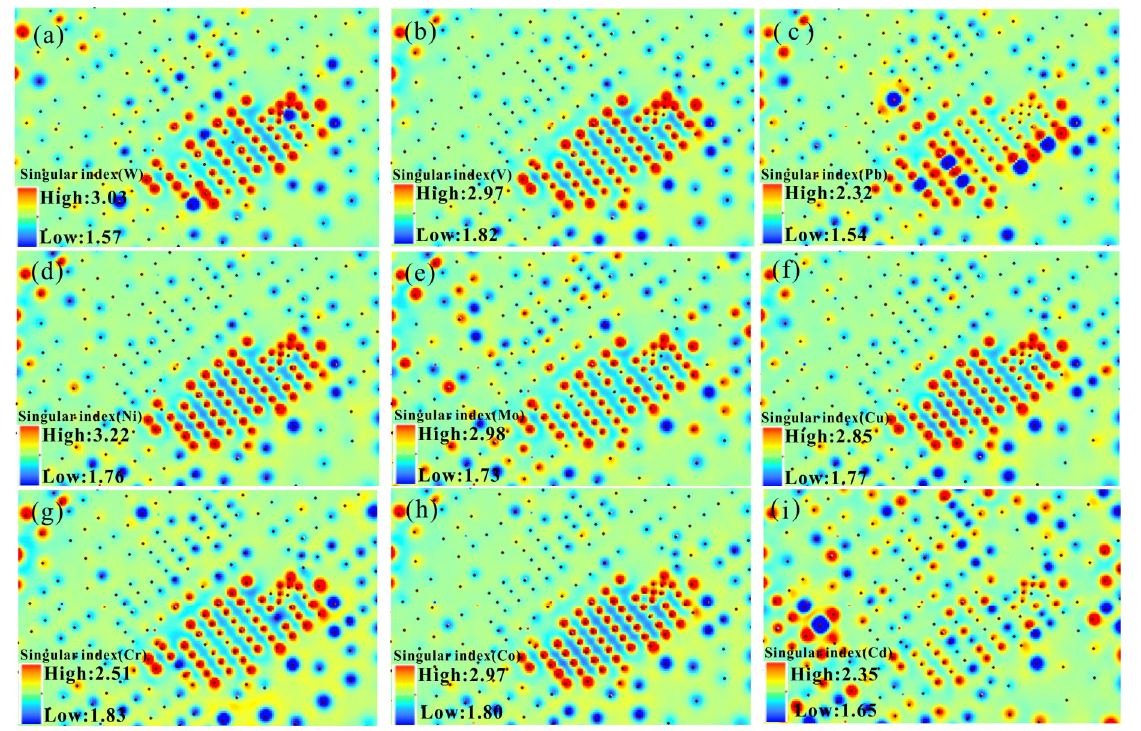
Figure 2. Distributions of singularities obtained for W, V, Pb, Ni, Mo, Cu, Cr, Co, and Cd, represented by ( a – i ),